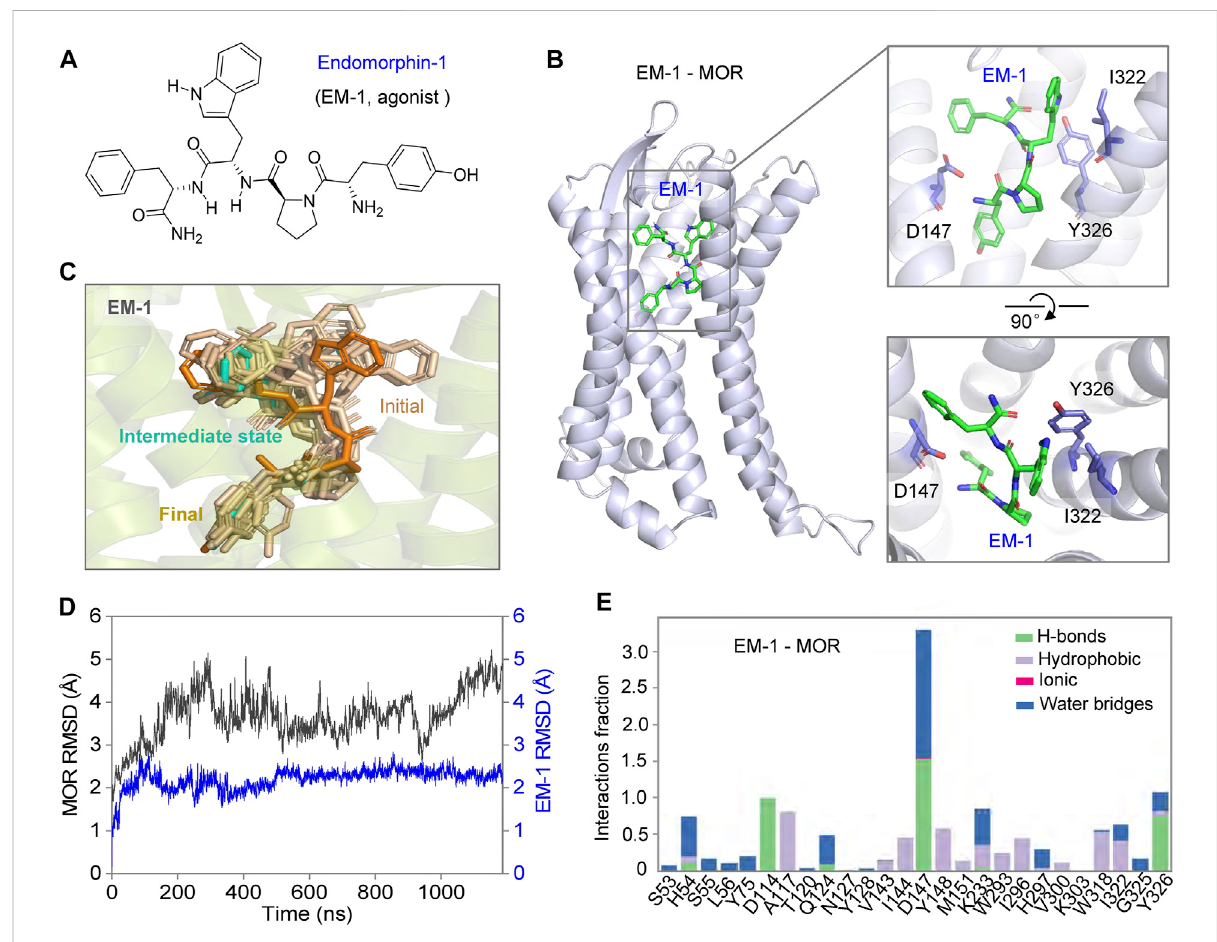
FIGURE 7 Possible dynamic bindingprocessofEM-1toMOR. (A) chemical structureofEM-1. (B) three-dimensionalmodeofrMORincomplexwithEM-1 and zoom-in side- ( upper ) and top views ( bottom ) of the binding pose of EM1-1 during MD simulations. The key sites that interact with EM-1 are shown as sticks for emphasis. (C) possible modes of EM-1 binding to MOR. The conformation of EM-1 is shown in different colors at different stages of the binding progress. (D) the C α -RMSD analysis of MOR and EM-1 throughout the binding progress of MD simulations. (E) analysis of the interactions between EM-1 and MOR, divided into four types and shown in different